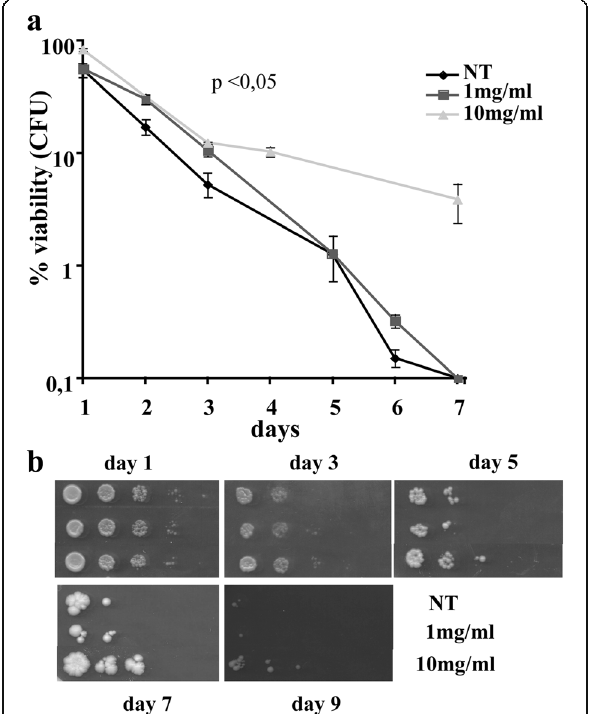
Fig. 1 Apple extracts can prolong cellular viability during chronological aging. a Cellular viability of Kllsm4 Δ 1 in the presence of the indicated concentrations of apple extracts during ageing. Viability, measured over time, is expressed as a percentage of colony forming units. b Dilution spot assay of Kllsm4 Δ 1 strain at the indicated days in the absence (NT) or in the presence of the indicated concentrations of apple extracts. Plates were recorded after 3 days of incubation at 28 °C. p